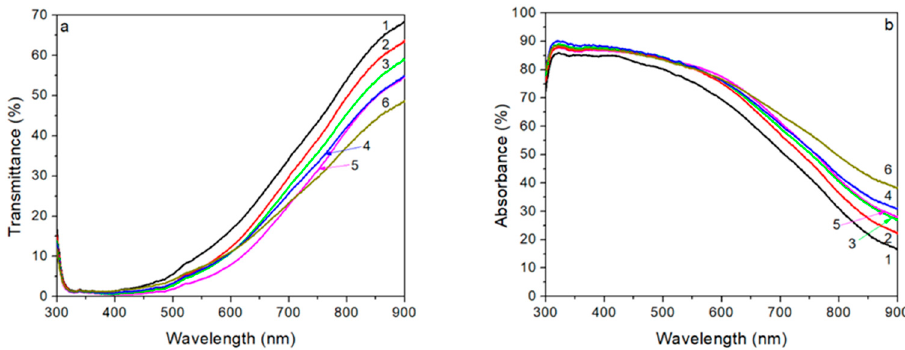
Figure 6. ( a ) Transmittance and ( b ) absorbance spectra of CuO thin films obtained at different temperatures, T s , K: (1) 600, (2) 625, (3) 650, (4) 675, (5) 700, (6) 725.